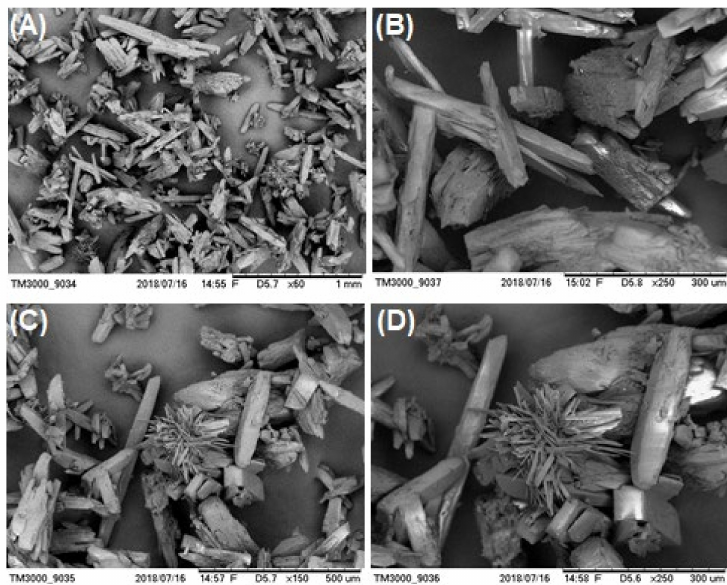
Figure 2. SEM images of pure piperine